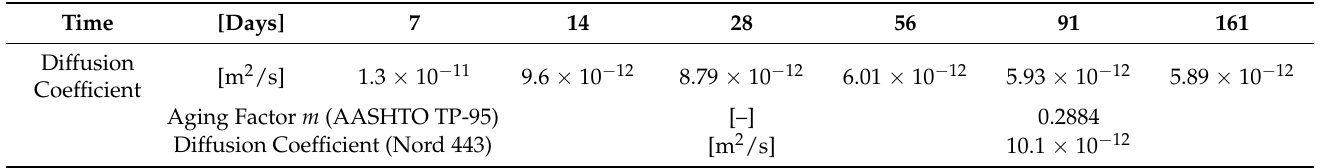
Table 3. Diffusion coefficient and aging